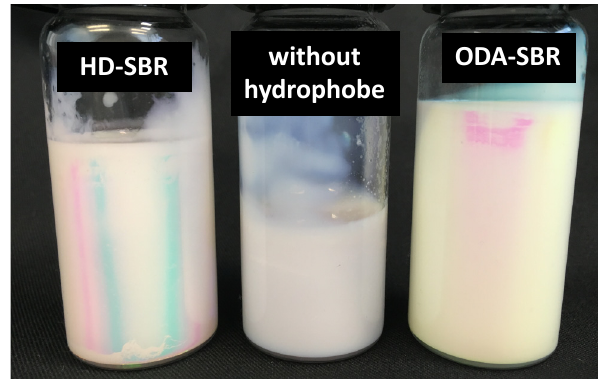
Figure 7. Macroscopic aspects of the SBR latexes synthesized based on the recipe in Table 2, using HD or ODA as the hydrophobe or without hydrophobe.